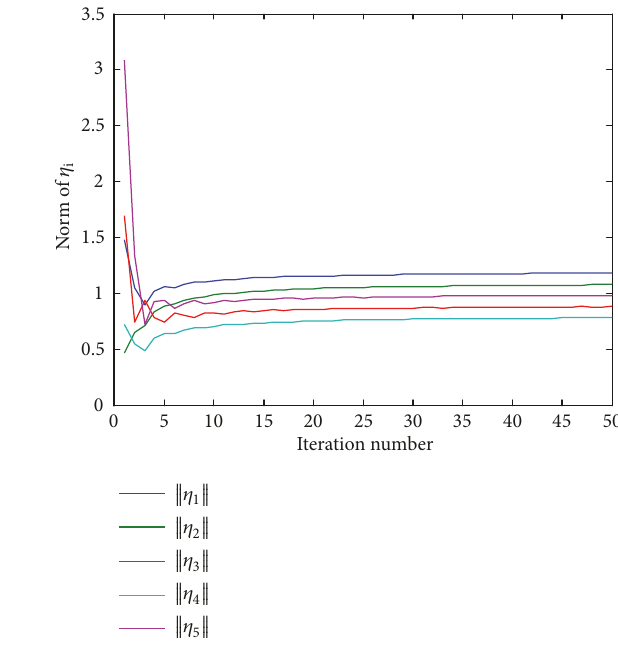
Figure 6: Response of 𝜂 𝑘 𝑖 (𝑡) .